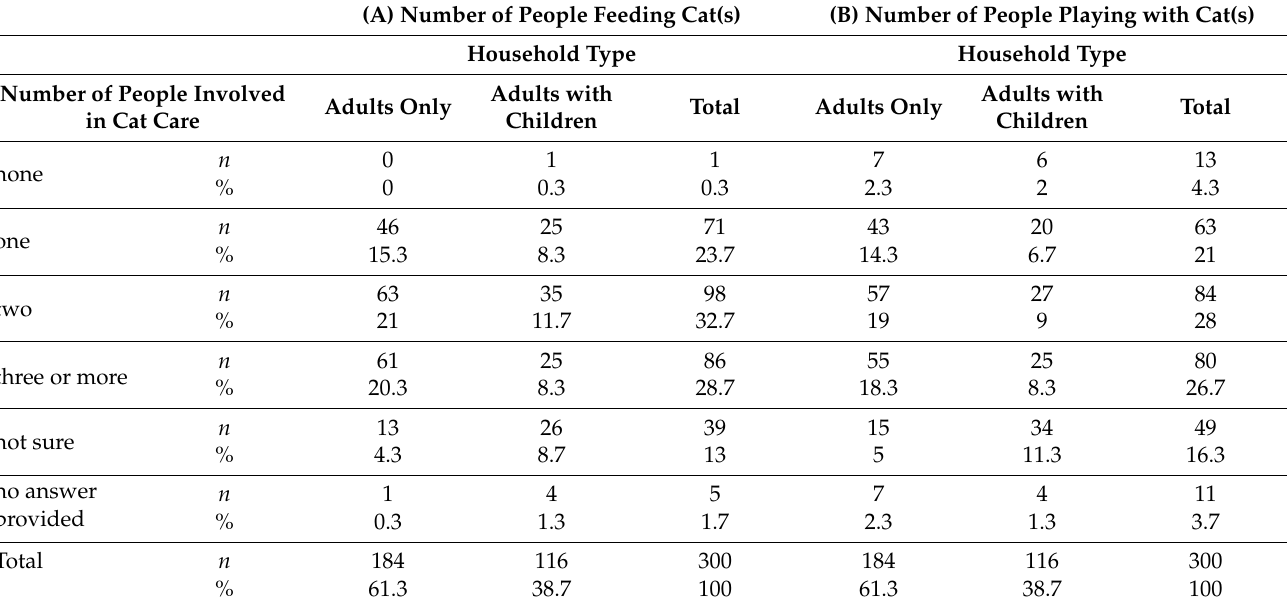
Table 4. Household with multiple occupancy ( n = 300) vs. number of people involved with cat(s)